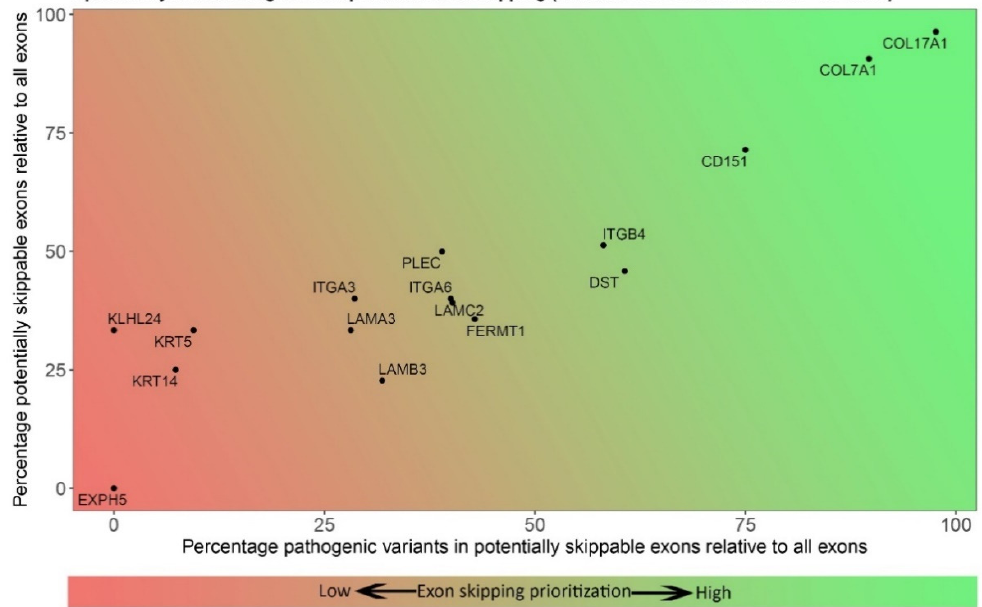
Figure 2. Prioritization tool for exon skipping development for EB. Visualization of the relative number of in-frame exons per EB-gene (Y-axis) and pathogenic variants (ClinVar) contained in them (X-axis). The further an exon lies within the green area, the greater the percentage of in-frame exons in that gene and the higher the percentage of variants located in those in-frame exons. This indicates that the gene is considered a good candidate for exon skipping development.